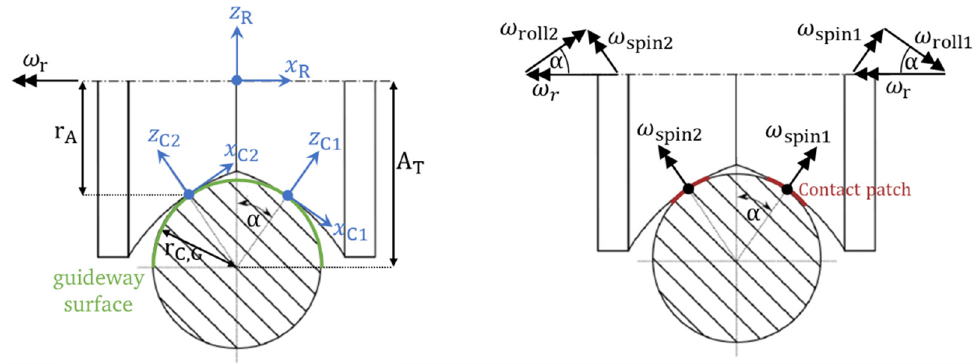
Figure 4. Coordinate systems and parameters ( left ), distribution of angular velocities ( right ). The angular velocity is first formulated as a vector in R-COS